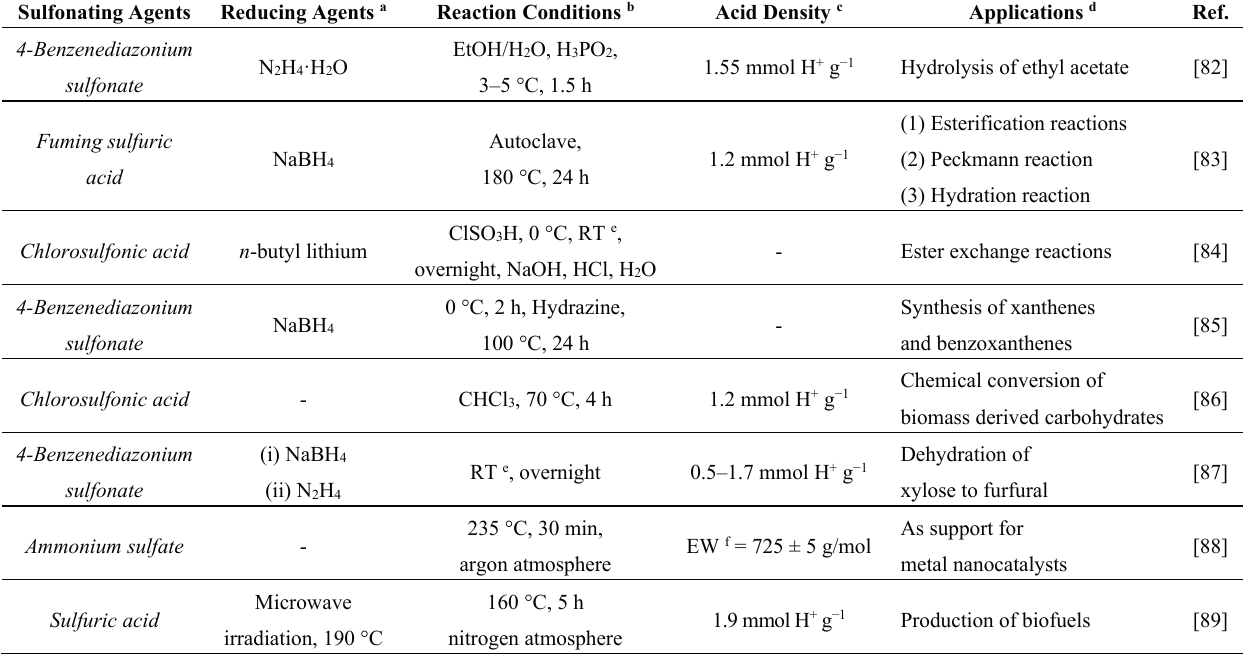
Table 2. List of sulfonating agents for (r)GO to